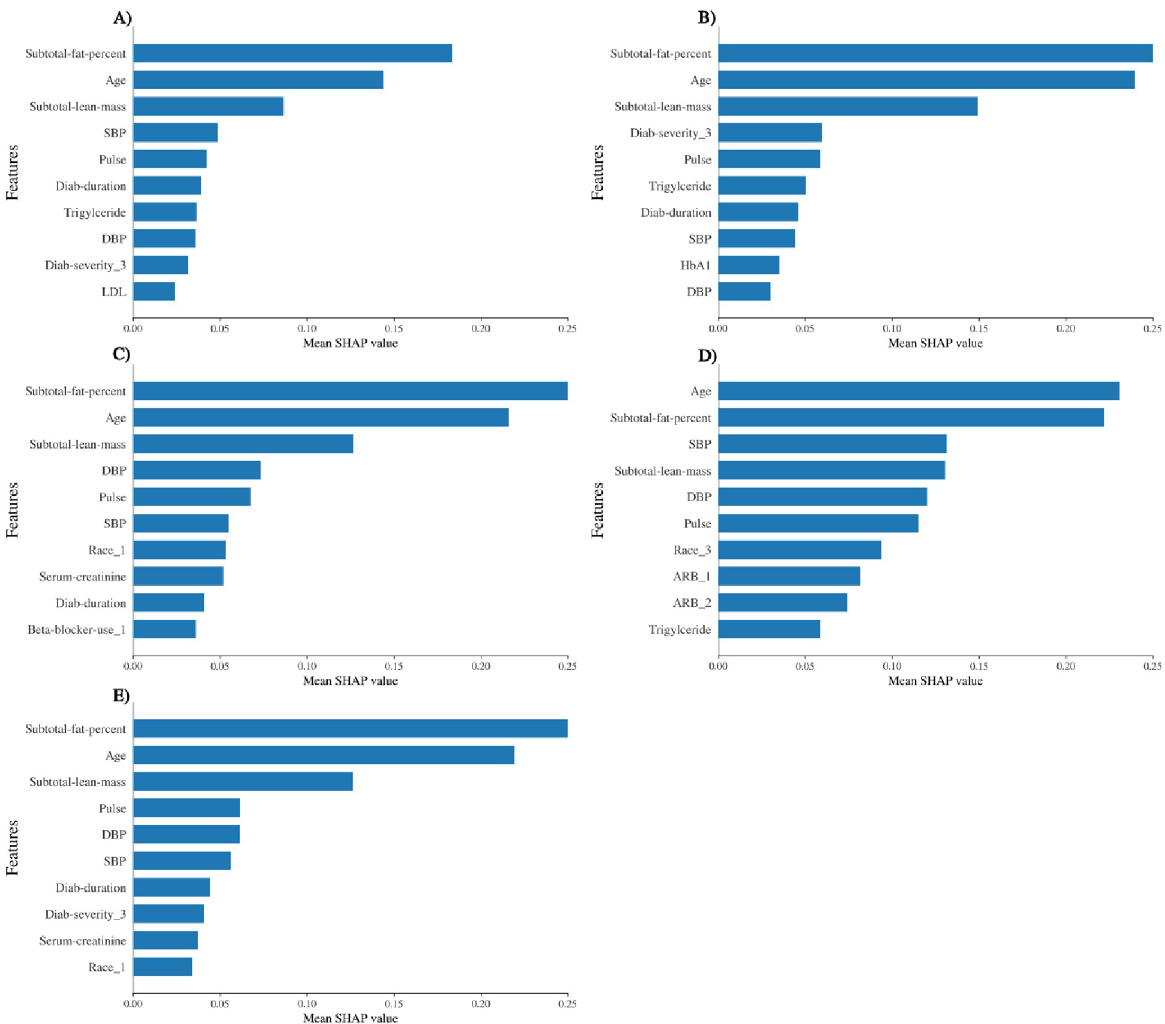
Fig 5. The top-10 ranked variables for each algorithm (A-E) by the mean shapley additive value for predicting the exercising capacity of females. A) Random Forest, B) Gradient boosting, C) Support vector regression, D) Multilayer perceptron, E) Stacking regressor.